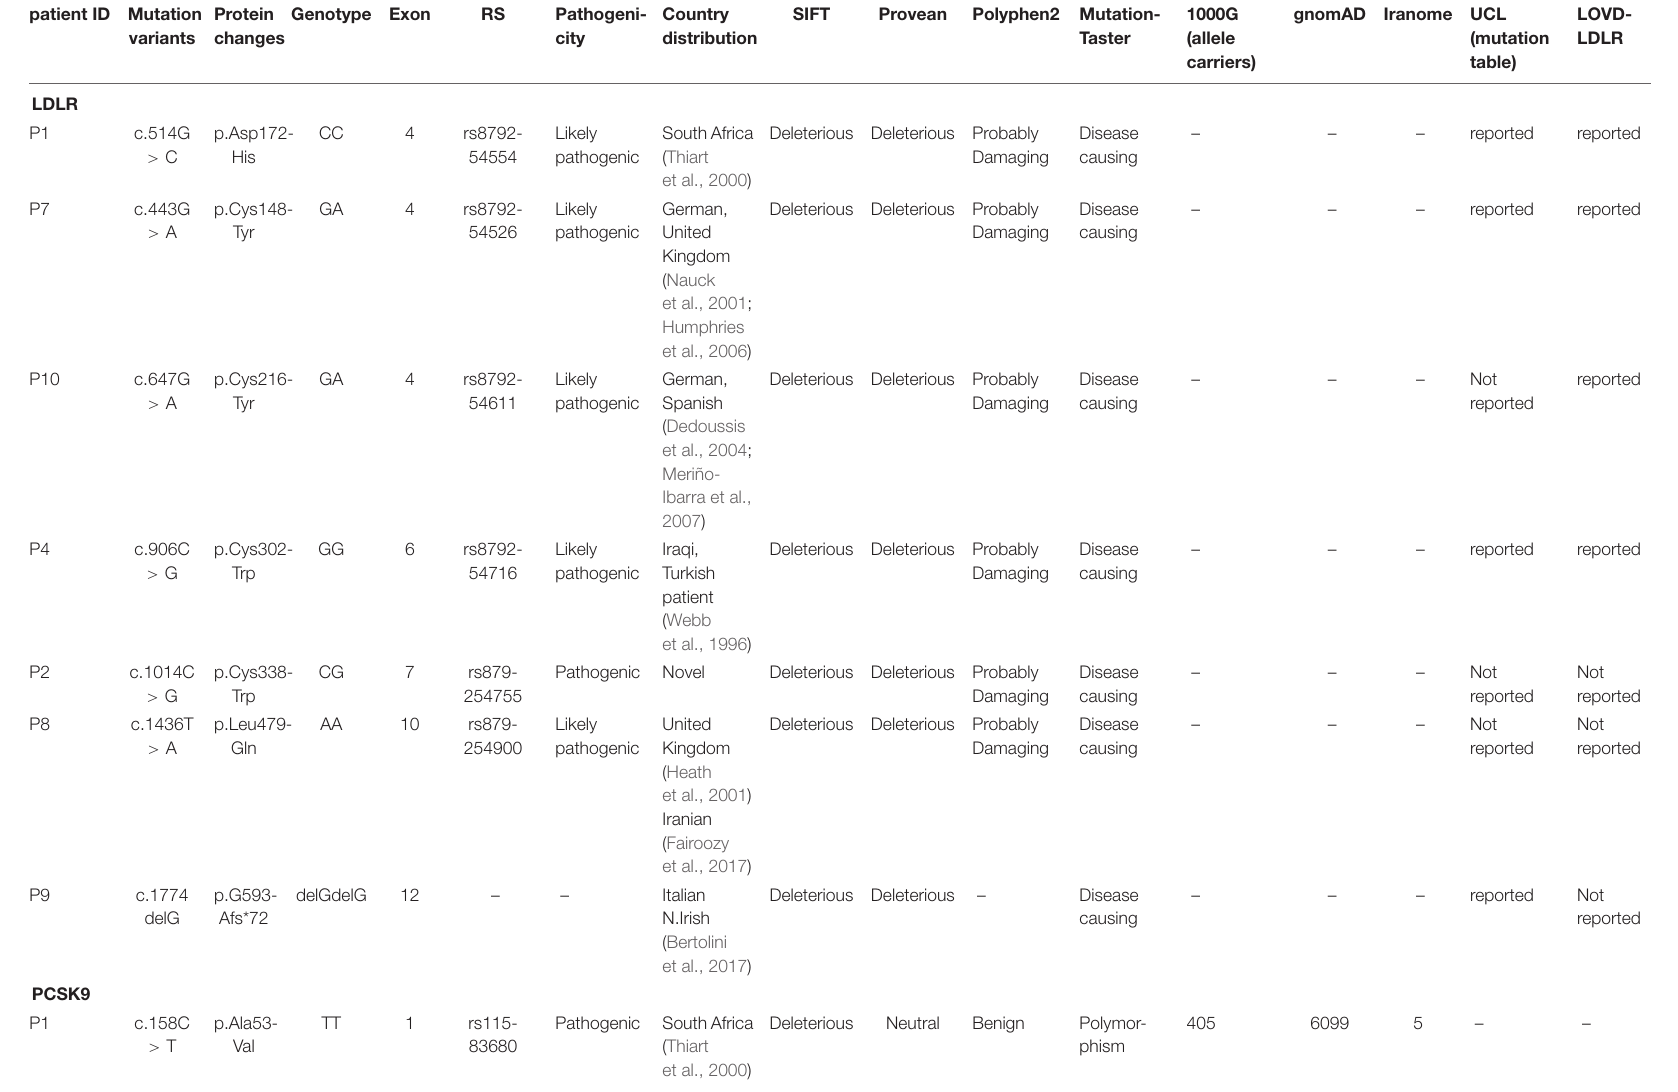
TABLE 2 | The pathogenic mutations of LDLR and PCSK9 genes detected in this study. patient ID Mutation Protein Genotype variants changes